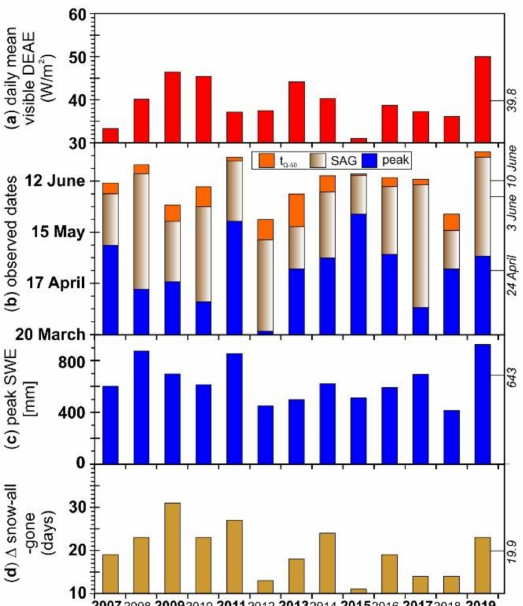
Figure 5. Annual ( a ) estimated daily mean visible dust enhanced energy absorbed (DEAE), ( b ) ob- served peak SWE (Figure 3a) and snow-all-gone (SAG) date, ( c ) peak SWE, and ( d ) modeled difference in SAG ( ∆ SAG) for a clean vs. dust present snowpack. The mean for each time series is noted on the right vertical